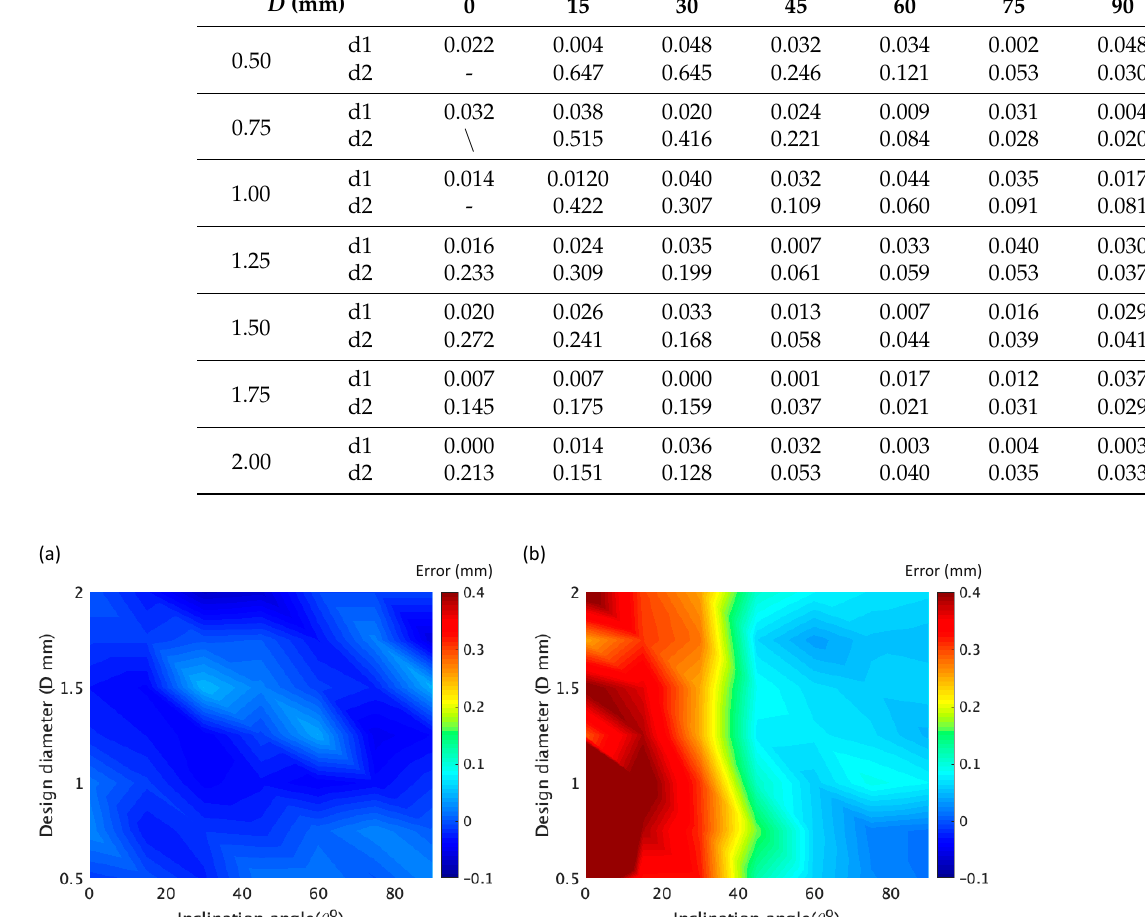
Figure 7. ( a ) Coupled influence of design diameter D and inclination angle θ on error ε of the horizontal dimension d1 of the rod unit. ( b ) Coupled influence of D and θ on ε of the longitudinal dimension d2 of the rod unit; d1 and d2 are indicated in Figure 6.